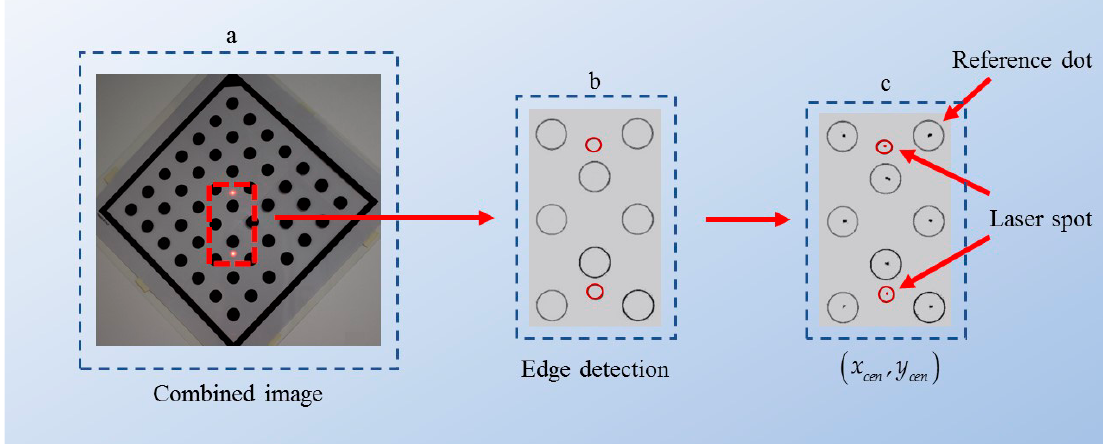
Figure 5. The process of detection. ( a ) The combined image sample; ( b ) edge detection; ( c ) centrioid coordinate calculation.